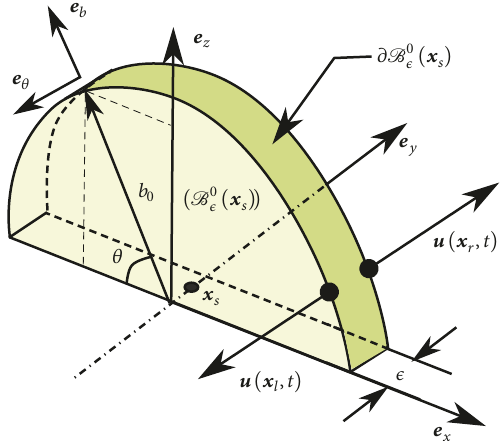
Figure 3: A freehanded sketch of the elementary domain B 0 𝜖 ( x 𝑠 ) in R 3